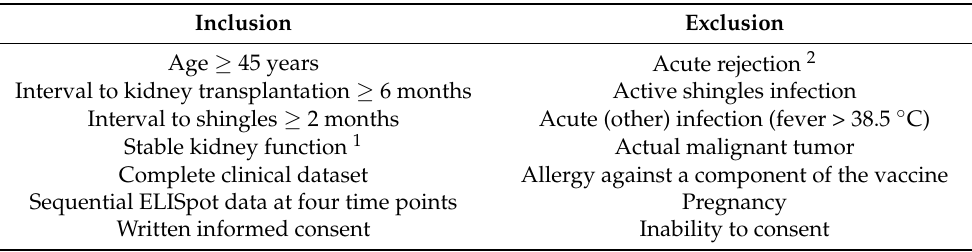
Table 1. Inclusion and exclusion